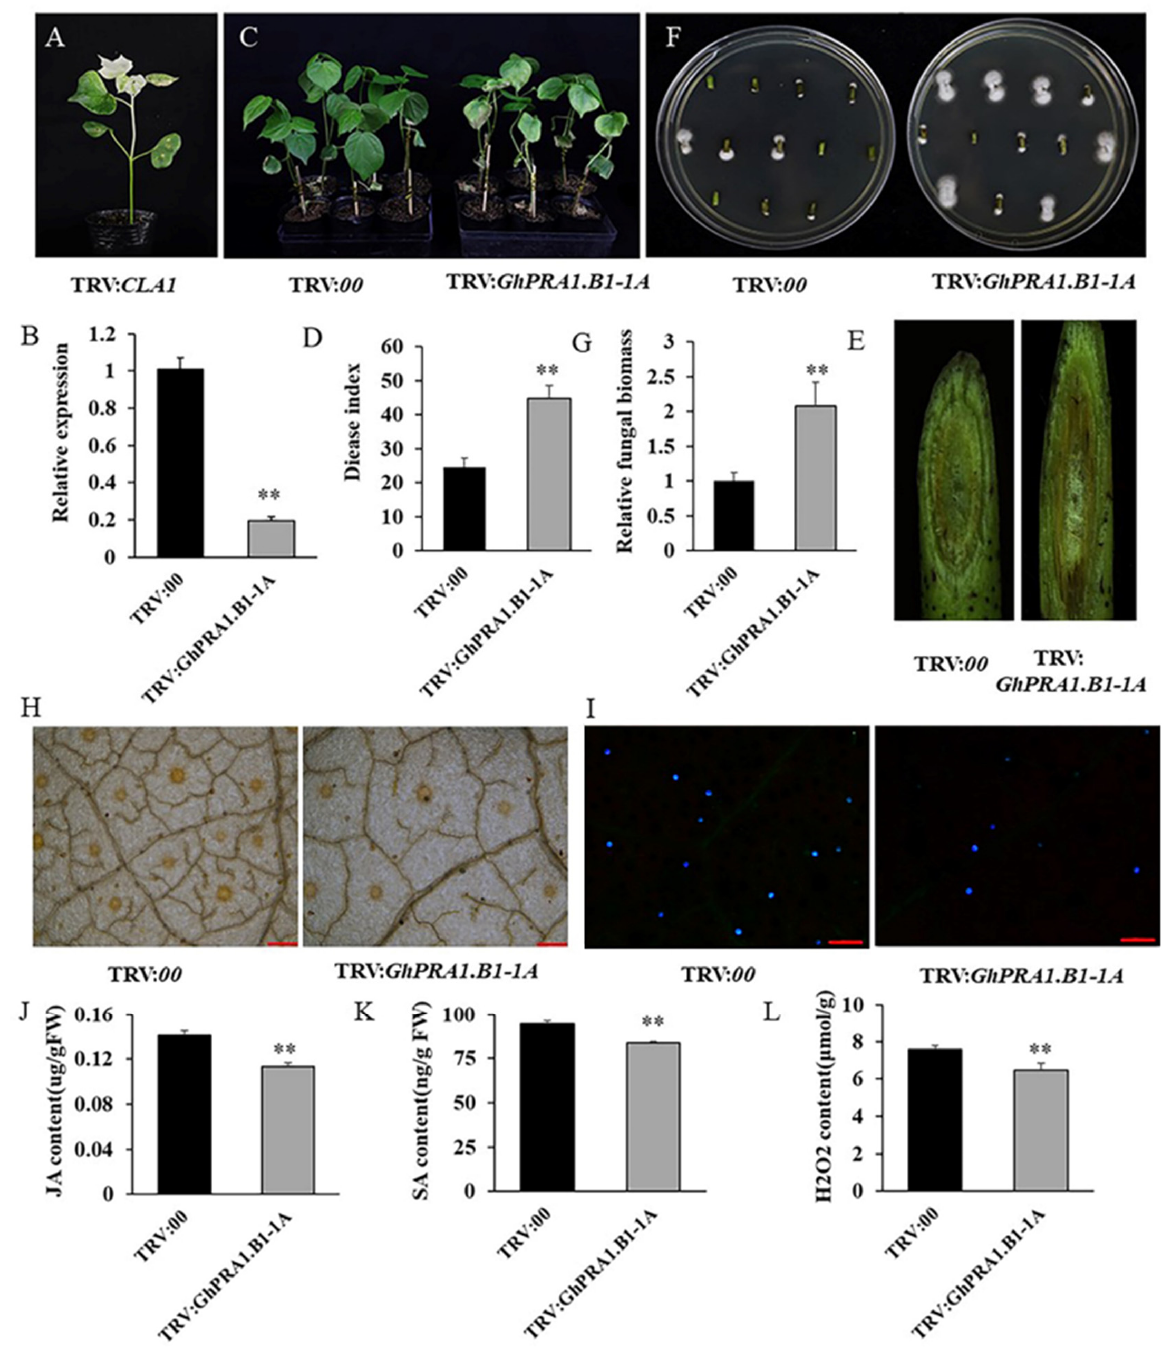
Figure 8. Silencing GhPRA1.B1-1A weakened V. dahliae resistance in upland cotton plants. ( A ) The photobleached phenotype after infection by TRV: GhCLA1 . ( B ) Detection of the expression levels of the GhPRA1.B1-1A gene in GhPRA1.B1-1A -silenced plants. ( C ) Phenotypes of control (TRV:00) and TRV: GhPRA1.B1-1A plants. ( D ) DI after 21 days of Vd991 infection. ( E ) Observation of the browning degree in stem vascular bundles. ( F , G ) The degree of fungal colonization and relative fungal biomasses of TRV:00 and TRV: GhPRA1.B1-1A . ( H ) At 48 h after inoculation, the levels of ROS were detected by DAB; bar = 200 µ m. (I) Callose deposition in TRV:00 and TRV: GhPRA1.B1-1A cotton leaves; bar = 200 µ m. ( J ) JA contents of TRV:00 and TRV:GhPRA1.B1-1A . ( K ) SA contents of TRV:00 and TRV:GhPRA1.B1-1A . ( L ) H 2 O 2 contents of TRV:00 and TRV:GhPRA1.B1-1A . The difference was statistically significant (** p <